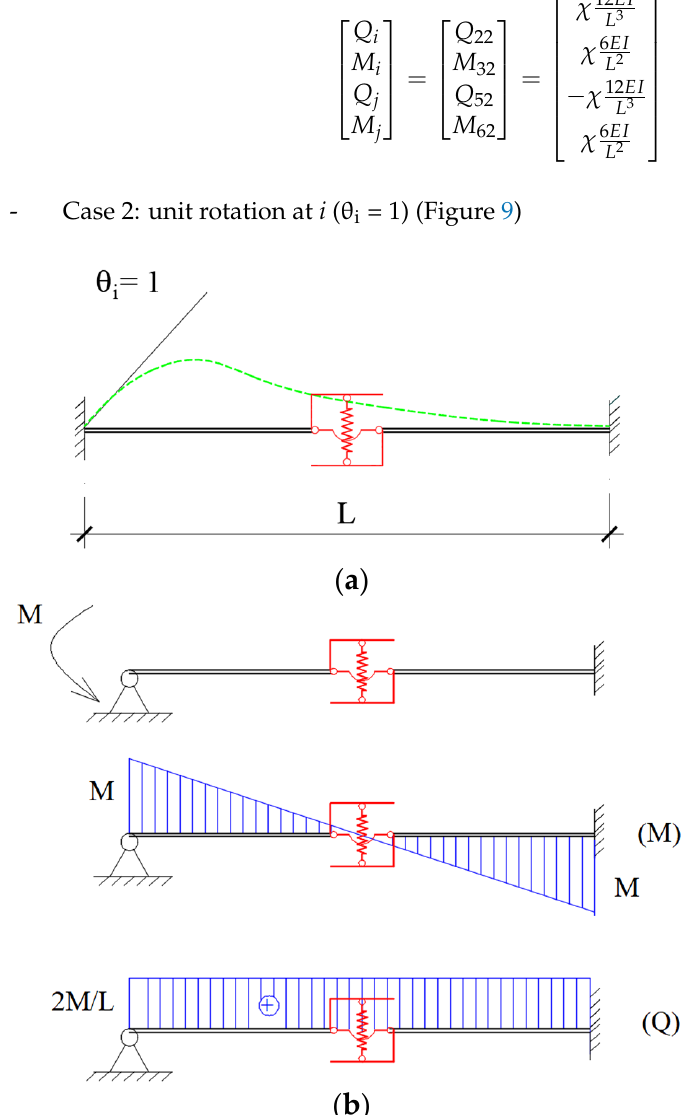
Figure 9. Elements of second column: ( a ) Unit rotation at end i; ( b ) Internal force diagrams when unit rotation at end i. Unit rotation is imposed at the i end of the beam while holding all other displacements to